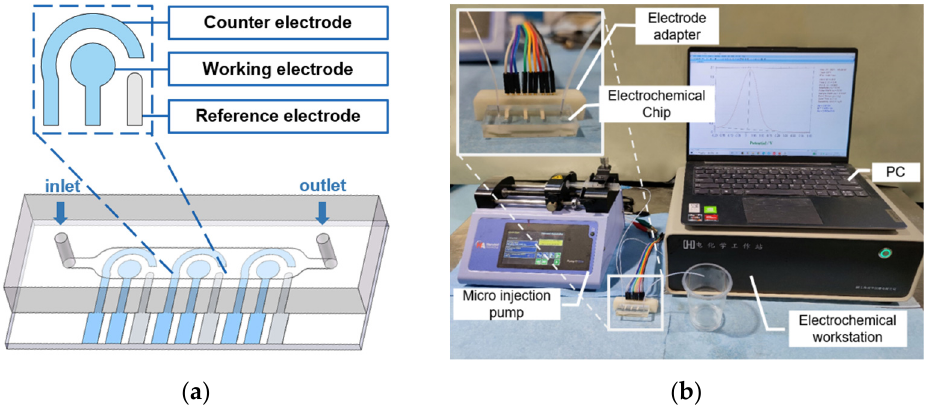
Figure 1. Schematic diagram of ( a ) the structure of electrochemical chip, ( b ) experimental setup.